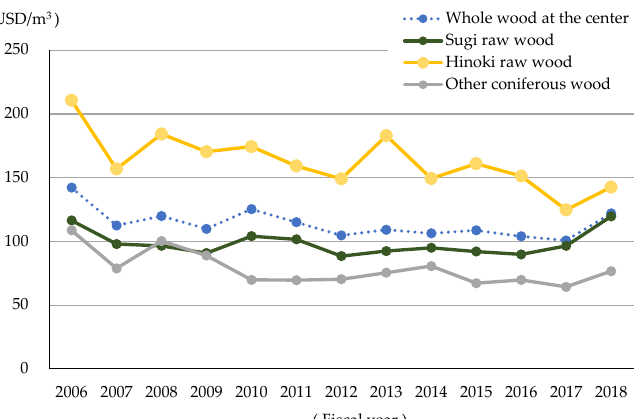
Figure 5. Average price (USD/m 3 ) of raw wood by tree type at Tama Roundwood Market Center.